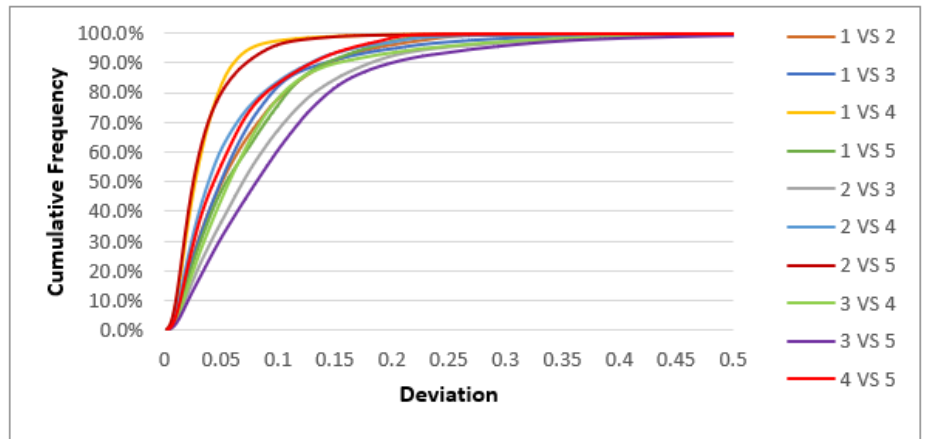
Figure 3. Deviation distribution as cumulative frequency: interscan comparison (scan number vs. scan number).